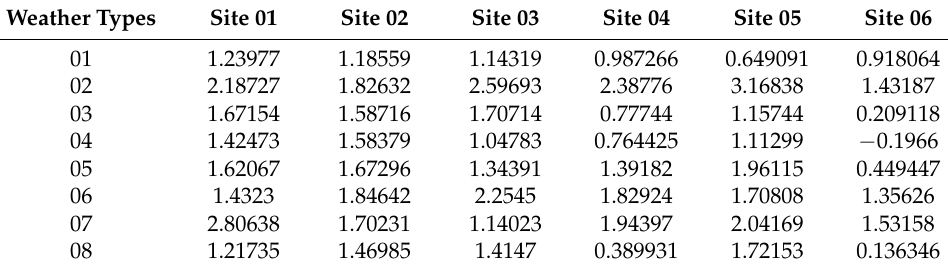
Table A2. Typical biases of 18 weather types in six wind